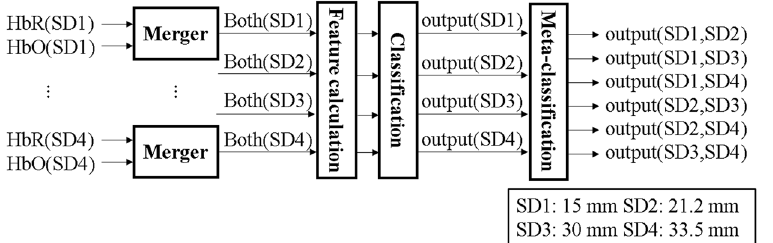
Figure 3. Data processing flow for classification. A feature vector was constructed by concatenating HbR and HbO, for the channels that remained after channel rejection. The classifier outputs, for each SD separation, were concatenated in pairs, to construct a feature vector for meta-classification.